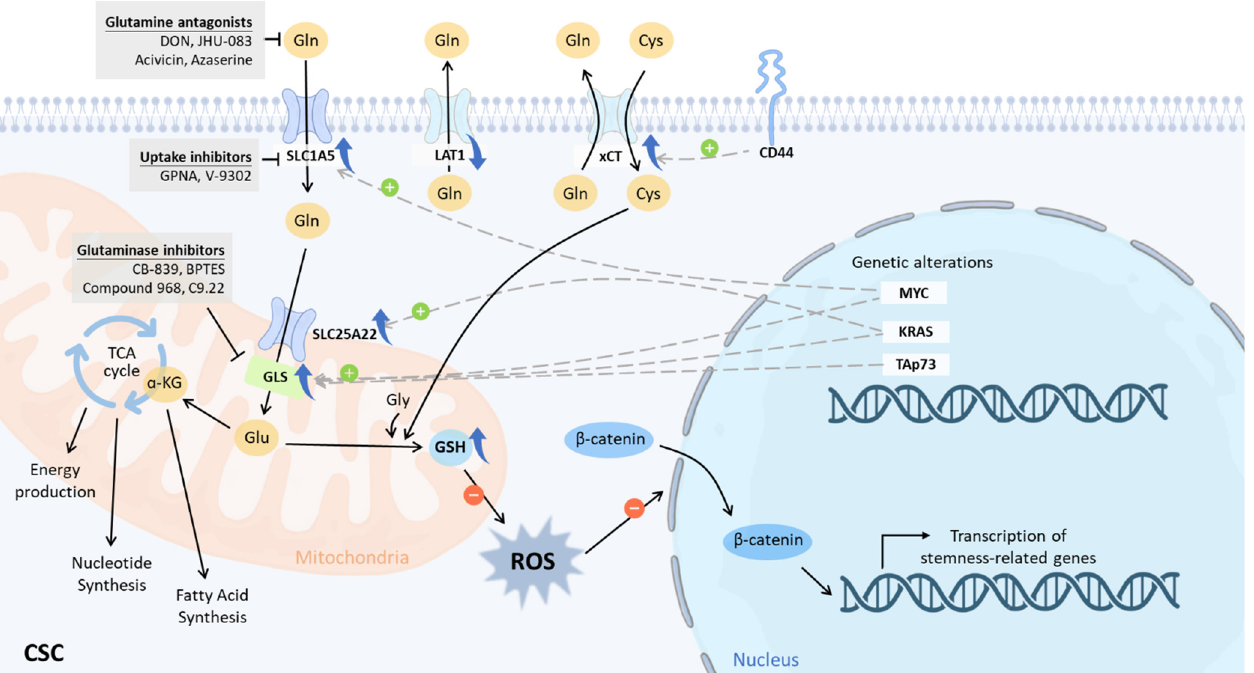
Figure 2. The glutaminolysis pathway and its inhibitors. Glutamine is the most prevalent amino acid in the blood and serves as a fuel source for the biosynthesis of fatty acids, nucleotides, and antioxidants in CSCs. MYC has the ability to raise the expression levels of the glutamine transporter ASCT2 as well as glutaminase. The glutaminolysis inhibitors include glutamine analogues such as DON, JHU-083, and acivicin azaserine, as well as glutaminase inhibitors such as CB-839, BPTES, compound 968, and C9.22. These inhibitors have the ability to prevent CSCs from engaging in metabolic compensation and from exhibiting aggressive phenotypes.